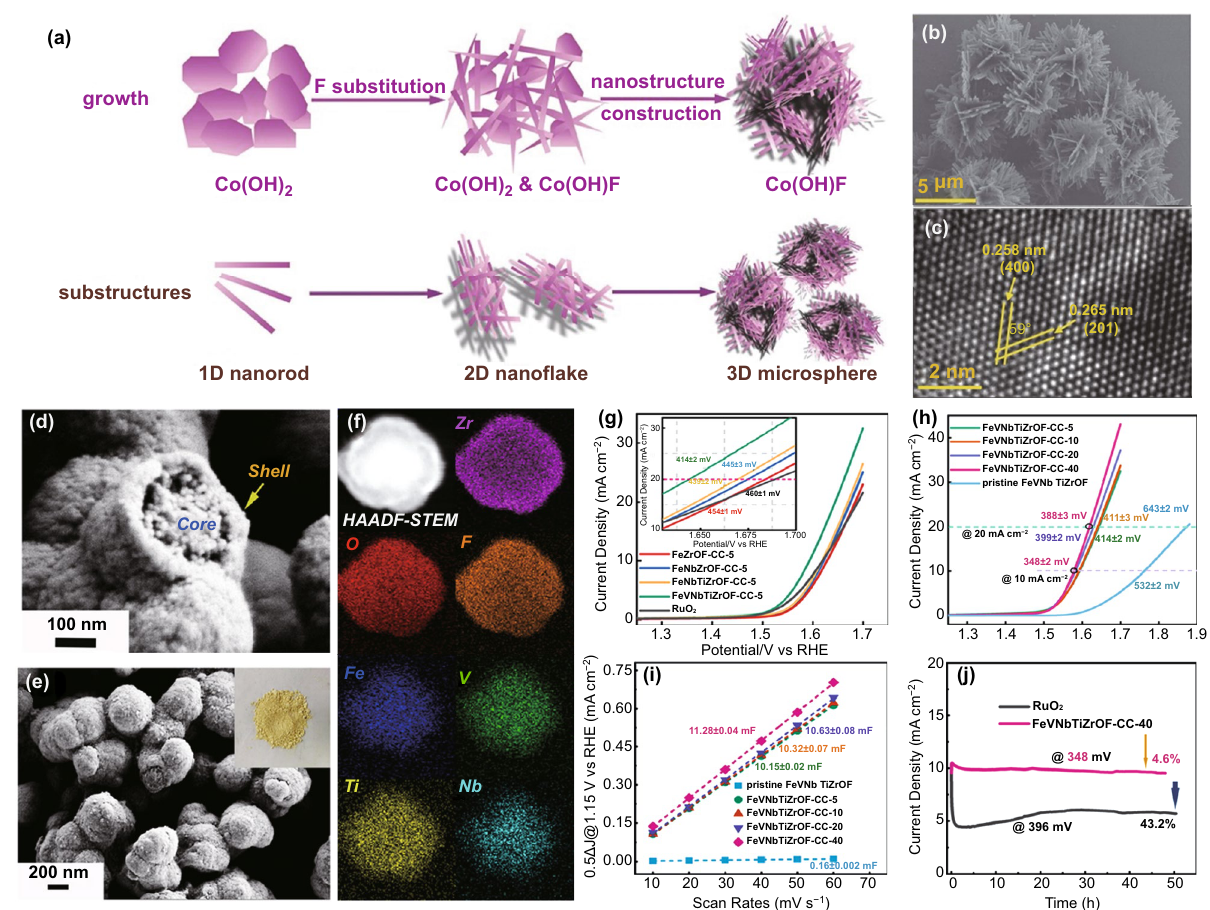
Fig. 6 a Schematic of the growth and substructures of the hierarchical 3D Co(OH)F microspheres. The 3D structure is constructed by 2D net- worked nanoflakes, and the 2D nanoflakes are further woven by the 1D nanorods, b SEM and c HRTEM images of the hierarchical 3D Co(OH)F microspheres. Reprinted with permission from Ref. [60]. Copyright Year 2017, Wiley–VCH Verlag GmbH & Co. KGaA, Weinheim. d–e SEM images and f EDS mappings of the pristine FeVNbTiZrOF, the insert map is the optical photo of the pristine FeVNbTiZrOF, g LSV curves of FeZrOF-CC-5, FeNbZrOF-CC-5, FeNbTiZrOF-CC-5, FeVNbTiZrOF-CC-5 and RuO 2 in 1 M KOH solution with a scan rate of 5 mV/s; h LSV curves of the pristine and activated FeVNbTiZrOF at different current densities; i corresponding linear plots of capacitive current densities ver- sus scan rates; j Chronoamperometric response of FeVNbTiZrOF-CC-40 and RuO 2 at the overpotential of 348 mV and 396 mV, respectively. Reprinted with permission from Ref. [113]. Copyright Year 2021,